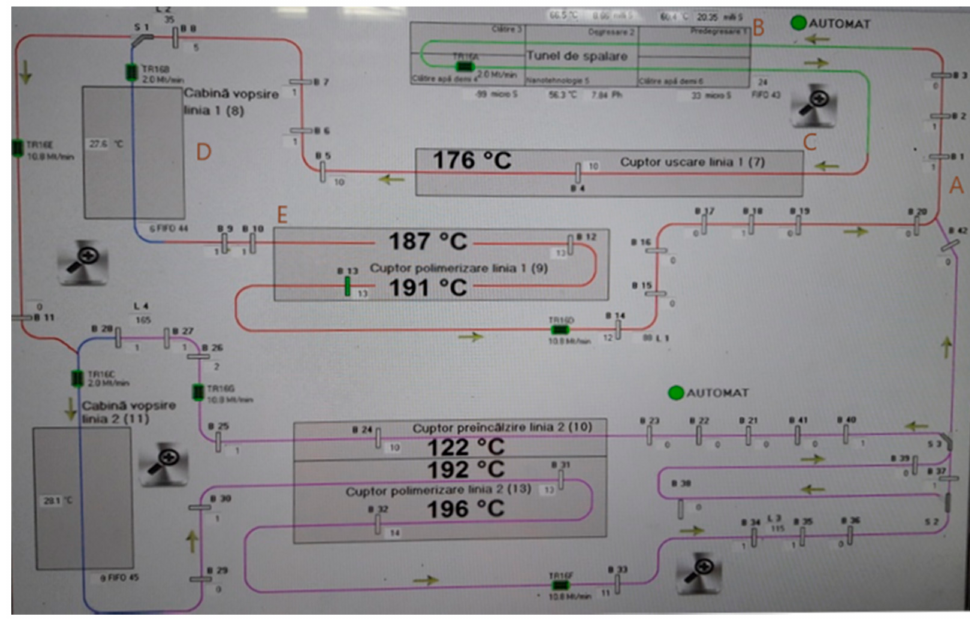
Figure 2. Painting